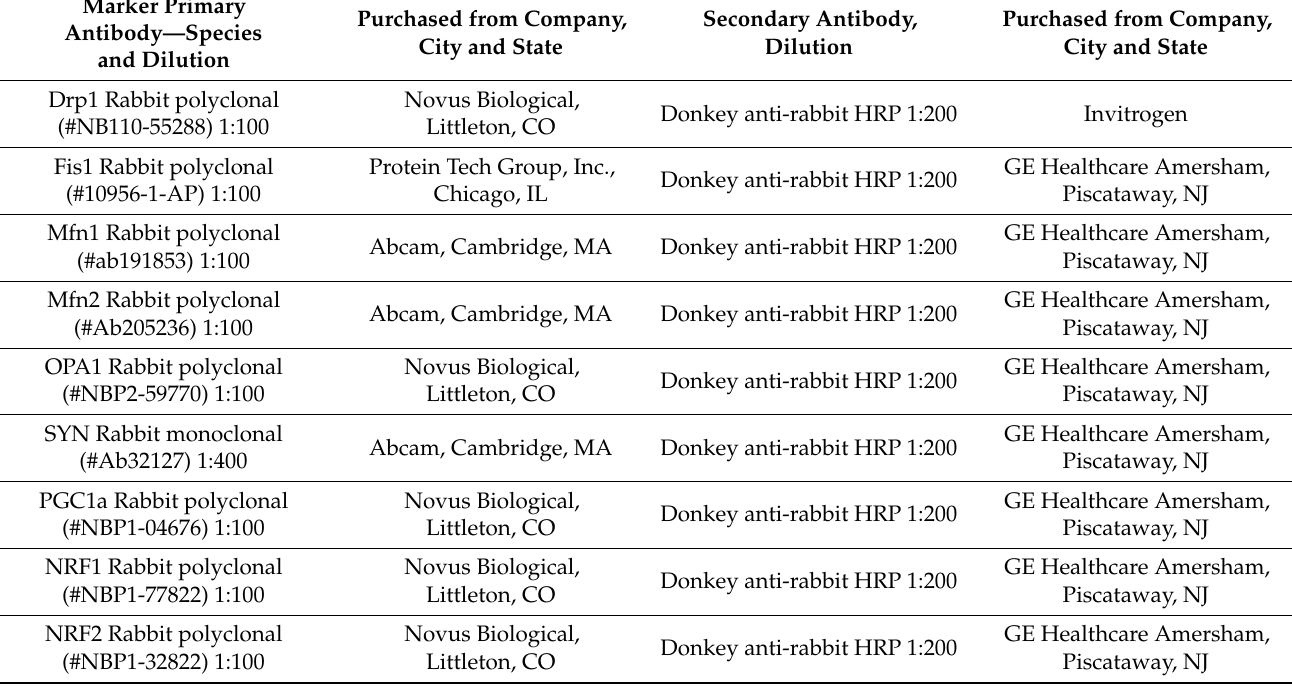
Table 2. Summary of antibody dilutions and conditions used in the immunofluorescence analysis of mitochondrial dynamics, mitochondrial biogenesis, synaptic mitophagy and autophagy proteins in mitophagy enhancer-treated and -untreated hAbKI